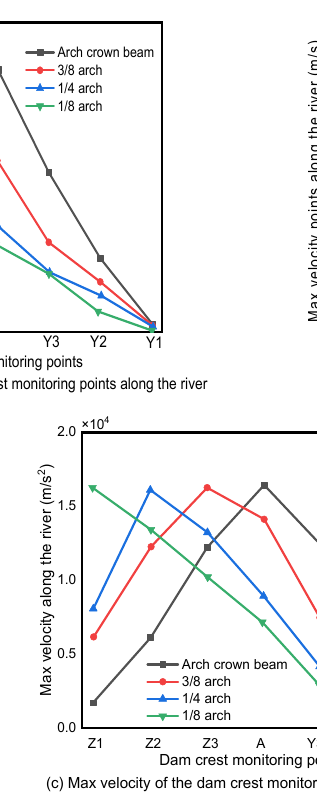
Figure 21. Dam crest monitoring points’ dynamic response at various horizontal detonation positions.